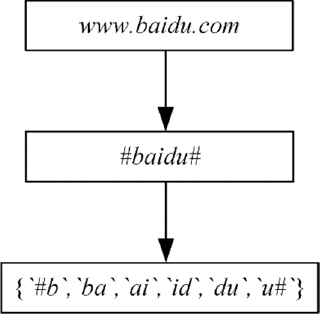
Figure 2. Word-hashing to process “ www.baidu.com ”.